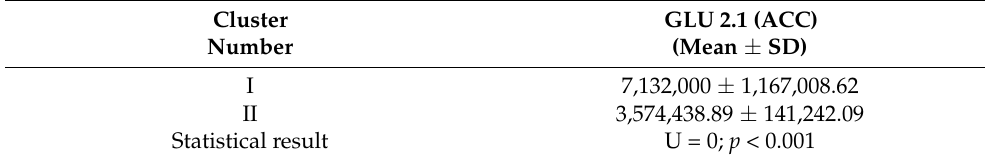
Table 1. Descriptive statistics for GLU 2.1 (ACC) in the selected clusters of patients with schizophrenia.